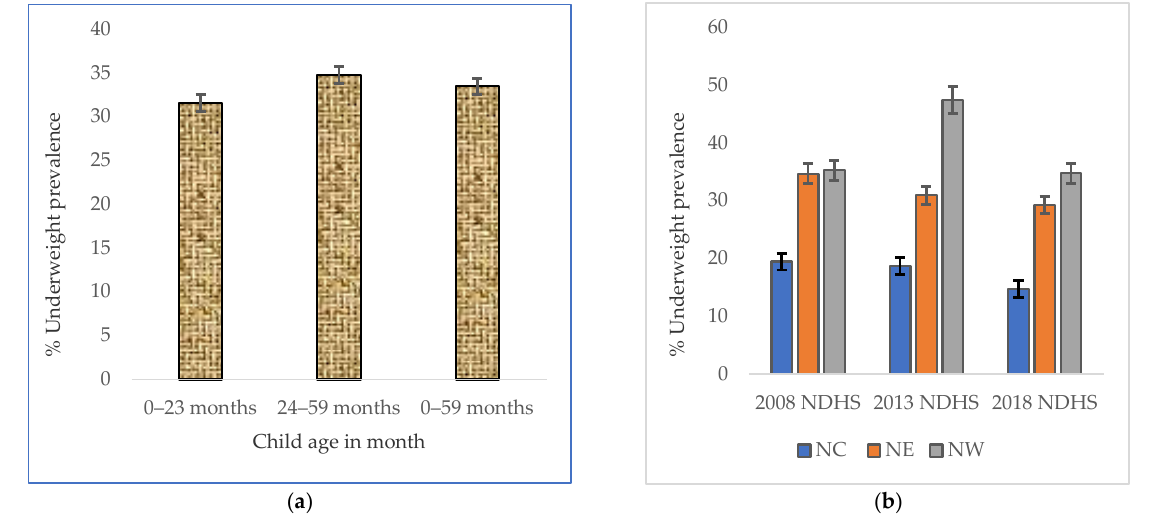
Figure 1. ( a ) The overall underweight prevalence in each of the sub-age groups in the NGZ, with a 95% confidence interval by age in months during the study period; ( b ) trends in prevalence of underweight children in the northern geopolitical zones (north central (NC), northeast (NE), and northwest (NW)) by year of Nigeria Demographic and Health Survey (NDHS).